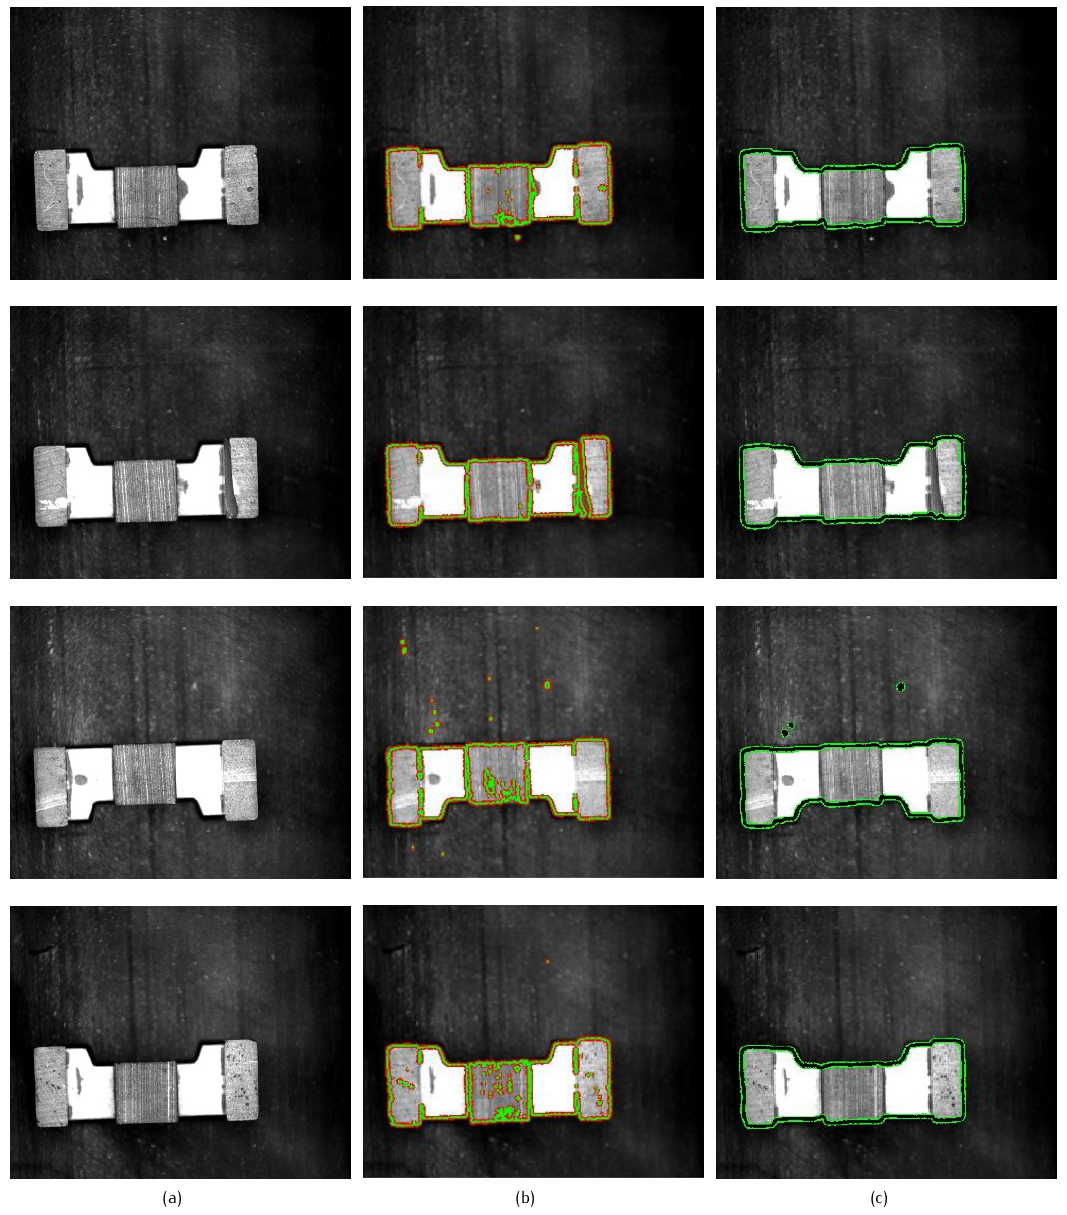
Figure 5. DemonstrationofdifferentunsupervisedsegmentationapproachesonE-shapedmagnetimages. (a)4typicalE-shapedmagnetimages. (b) Segmentation results yielded by CV model [13]. (c) Segmentation results produced by our proposed algorithm.